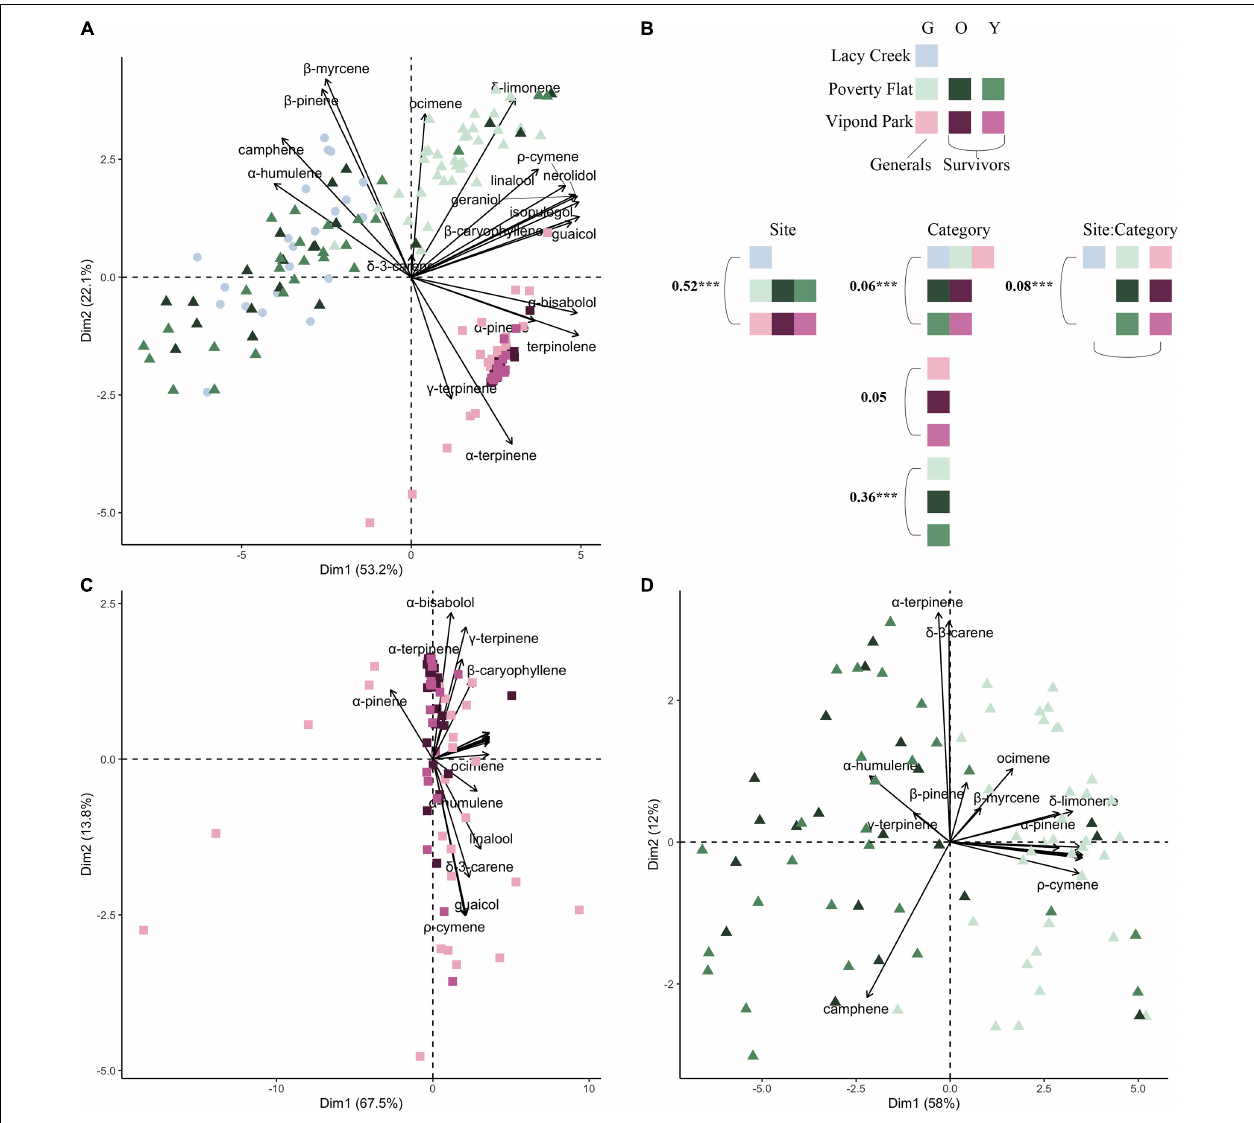
FIGURE 2 | Principal components analysis (PCA) of major compounds for generals and survivors for (A) all three sites, (C) Vipond Park, and (D) Poverty Flat. Each point is an individual tree. Community composition corresponds to the logit-transformed proportional composition. (B) Color used in PCAs denotes site and color intensity corresponds to generals (lightest tint), older survivors (darkest tint), and younger survivors (medium tint). First two axes are reported, and the percent variation explained is reported for each axis. Biplot vectors show direction and strength of significant correlations with major compounds. Simplified PERMANOVA results are presented where numbers correspond to the amount of variance explained ( R 2 for each PERMANOVA term) and stars denote significance at the α = 0.05 level. Full PERMANOVA tables are supplied in Supplementary Table 1